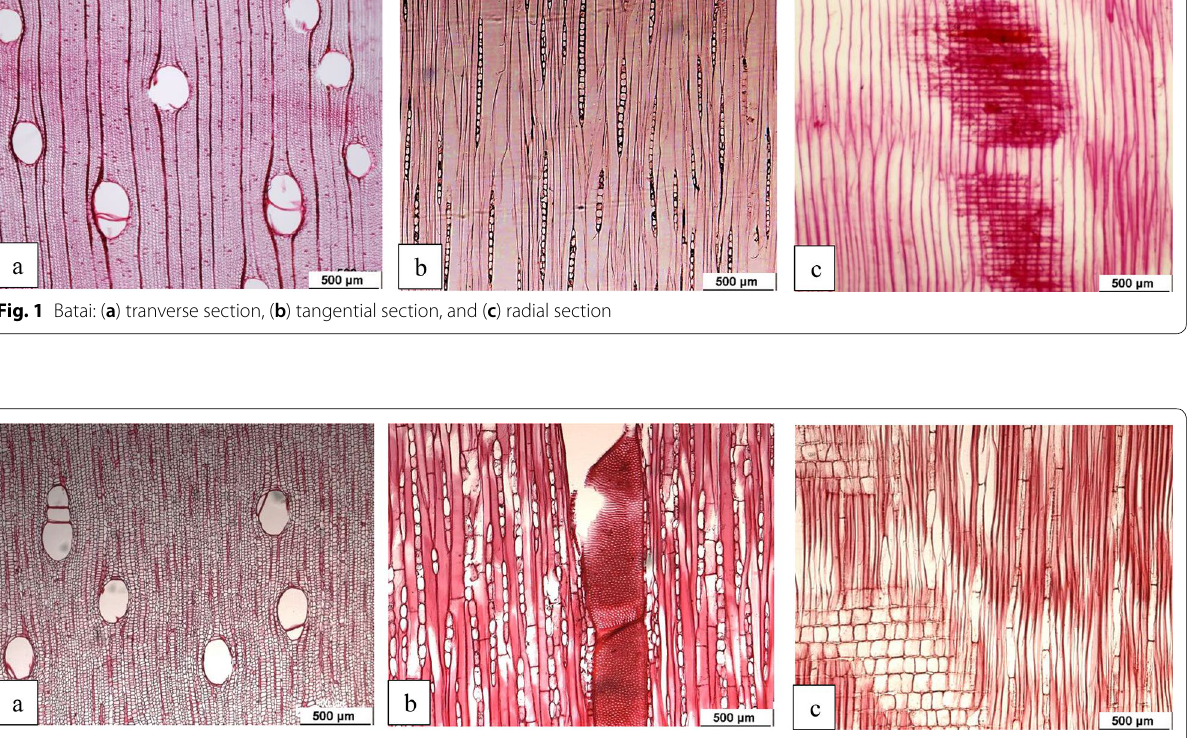
Fig. 2 Ludai: ( a ) tranverse section, ( b ) tangential section, and ( c ) radial